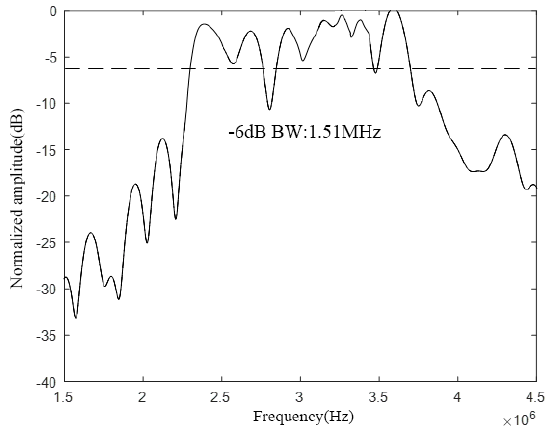
Figure 17. CMUT bandwidth ( w = 50%).